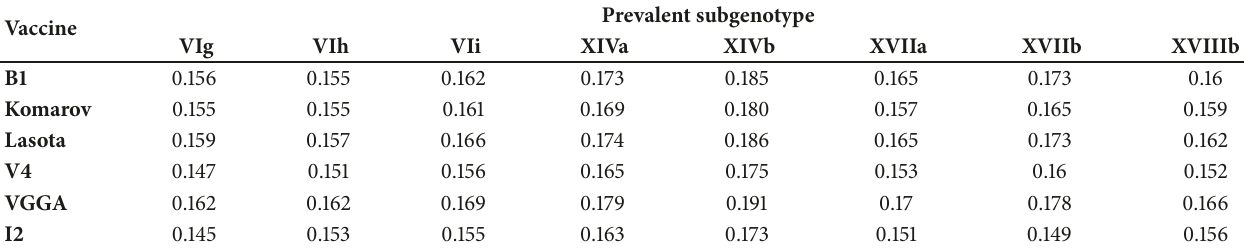
Table 4: Genetic distances between the common vaccine strains and the prevalent virulent NDV subgenotypes in Nigeria.